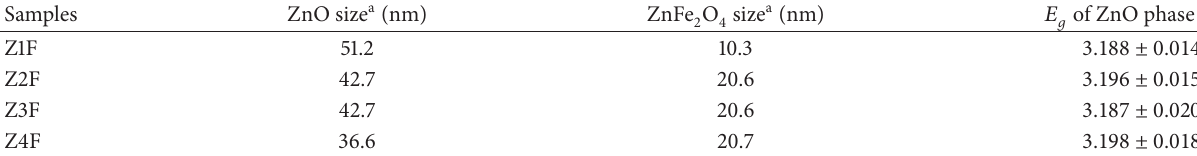
Table 1: Crystallite size and optical band-gap energy ( 𝐸 𝑔 ) for Z1F, Z2F, Z3F and Z4F samples. Samples